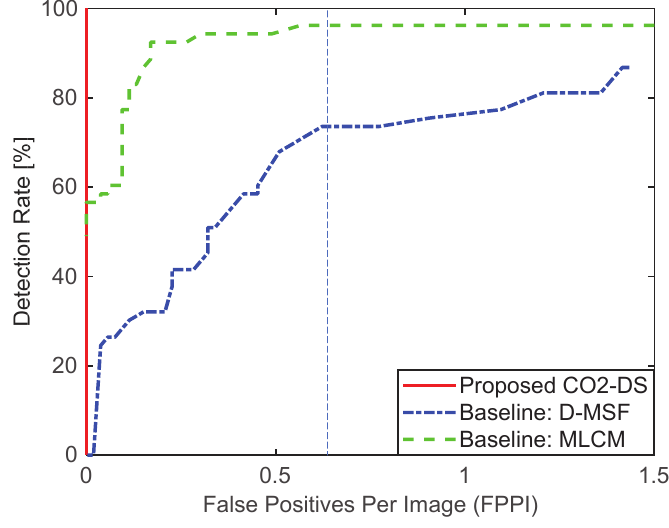
Figure 14. Receiver operating characteristic (ROC)-based comparison of detection performance.